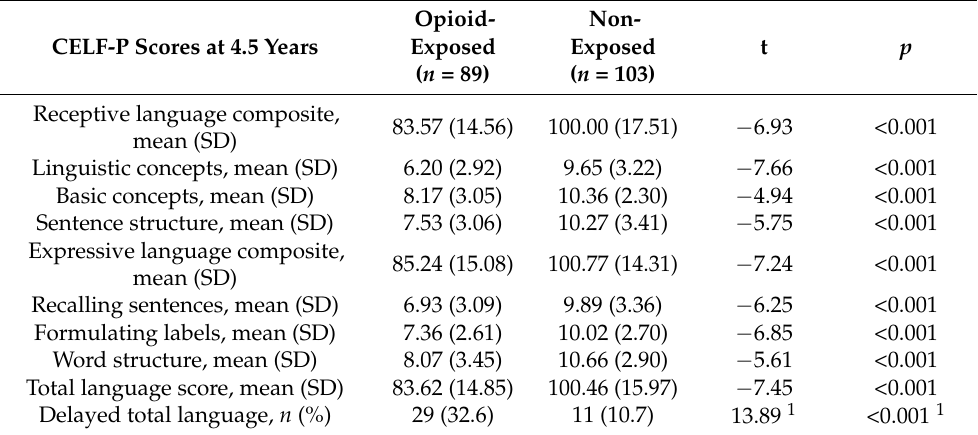
Table 2. Prenatal opioid exposure and language development at age 4.5 years: CELF-P scores. Non- Opioid- Exposed t p CELF-P Scores at 4.5 Years Exposed ( n = 103) ( n = 89) Receptive language composite, 83.57 (14.56) 100.00 (17.51) − 6.93 <0.001 mean (SD) Linguistic concepts, mean (SD) 6.20 (2.92) 9.65 (3.22) − 7.66 <0.001 Basic concepts, mean (SD) 8.17 (3.05) 10.36 (2.30) − 4.94 <0.001 Sentence structure, mean (SD) 7.53 (3.06) 10.27 (3.41) − 5.75 <0.001 Expressive language composite, 85.24 (15.08) 100.77 (14.31) − 7.24 <0.001 mean (SD) Recalling sentences, mean (SD) 6.93 (3.09) 9.89 (3.36) − 6.25 <0.001 Formulating labels, mean (SD) 7.36 (2.61) 10.02 (2.70) − 6.85 <0.001 Word structure, mean (SD) 8.07 (3.45) 10.66 (2.90) − 5.61 <0.001 Total language score, mean (SD) 83.62 (14.85) 100.46 (15.97) − 7.45 <0.001 29 (32.6) 11